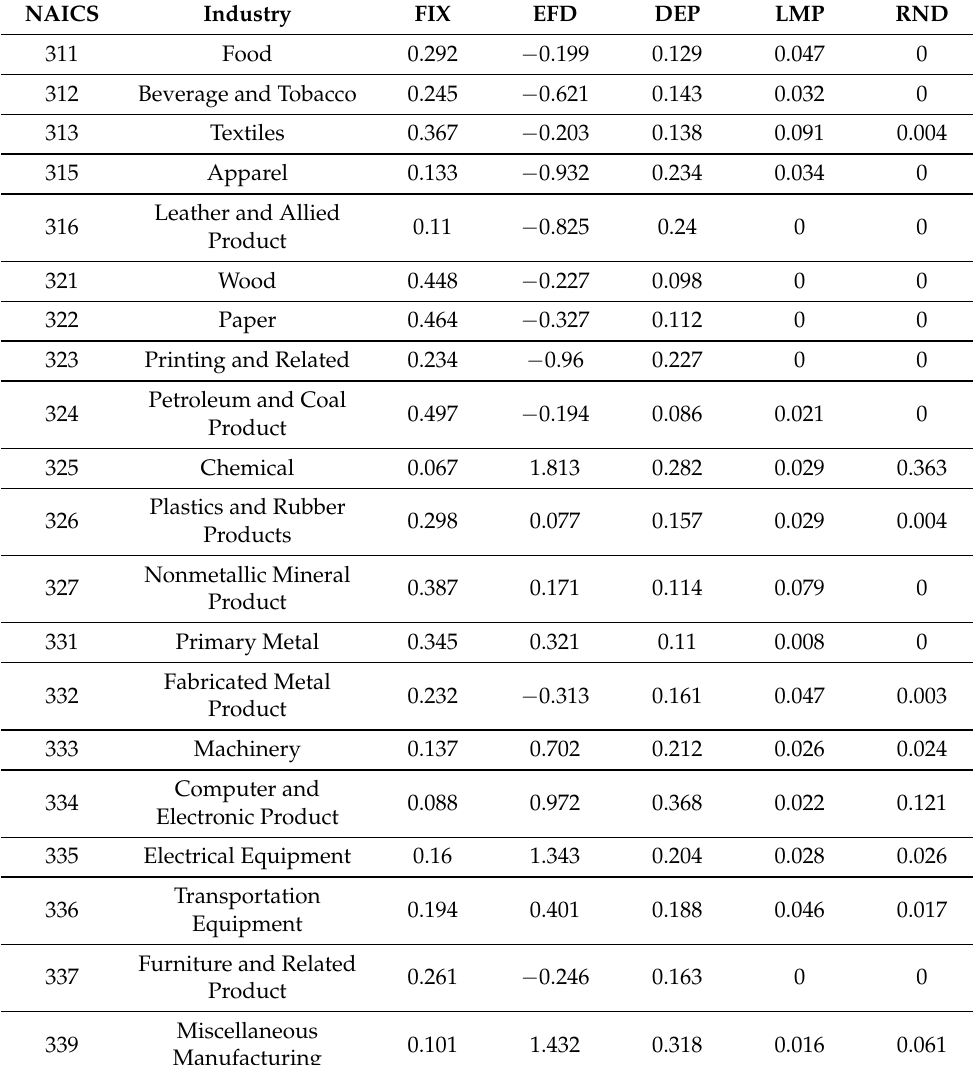
Table 7. Measurements of Technological